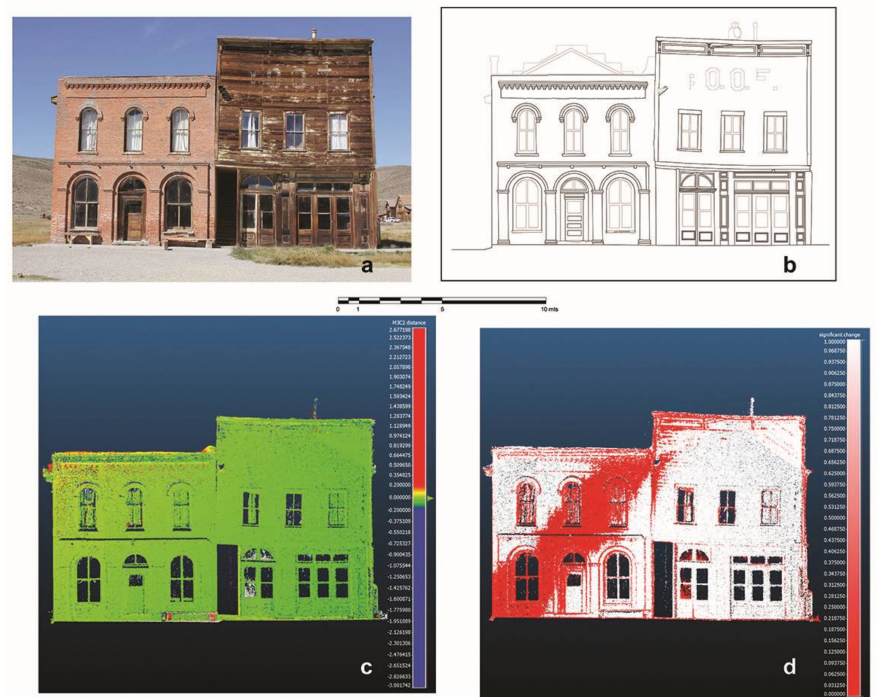
Figure 14. On-scale visualization of ( a ) photograph of the Dechambeau Hotel and IOOF Hall’s East façades; ( b ) architectural drawing showing no visible damage caused by the 2016 Hawthorne earthquake; ( c ) M3C2 distance map visualizing the surface change in centimeter between 2016 pre- disturbance dataset and 2017 post-disturbance dataset; ( d ) M3C2 significant change map highlighting invisible damage patterns. ( a ) By A. Guillem; ( b ) by A. Campiani; ( c , d ) by A. Guillem and C.